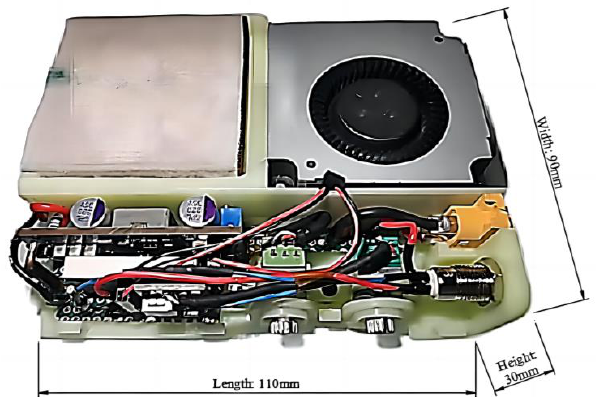
Figure 13. Physical diagram of the device (with the shell removed).